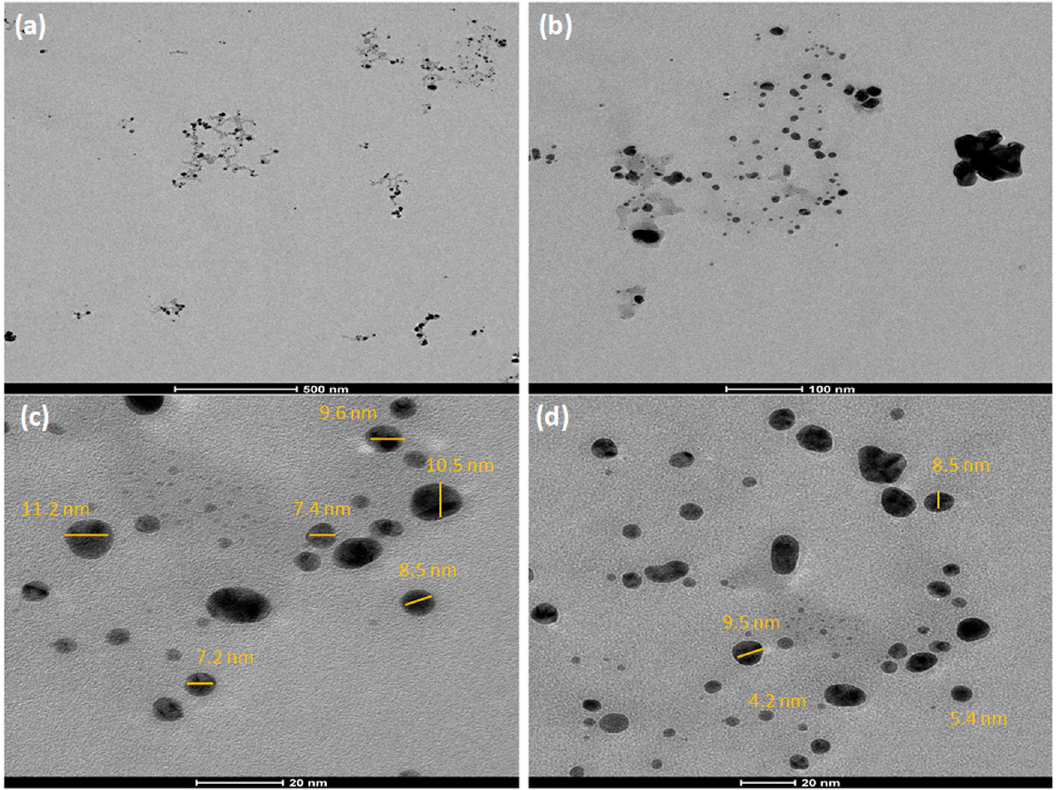
Figure 3: ( a and b ) Low magni fi ed; ( c and d ) high magni fi ed TEM images of